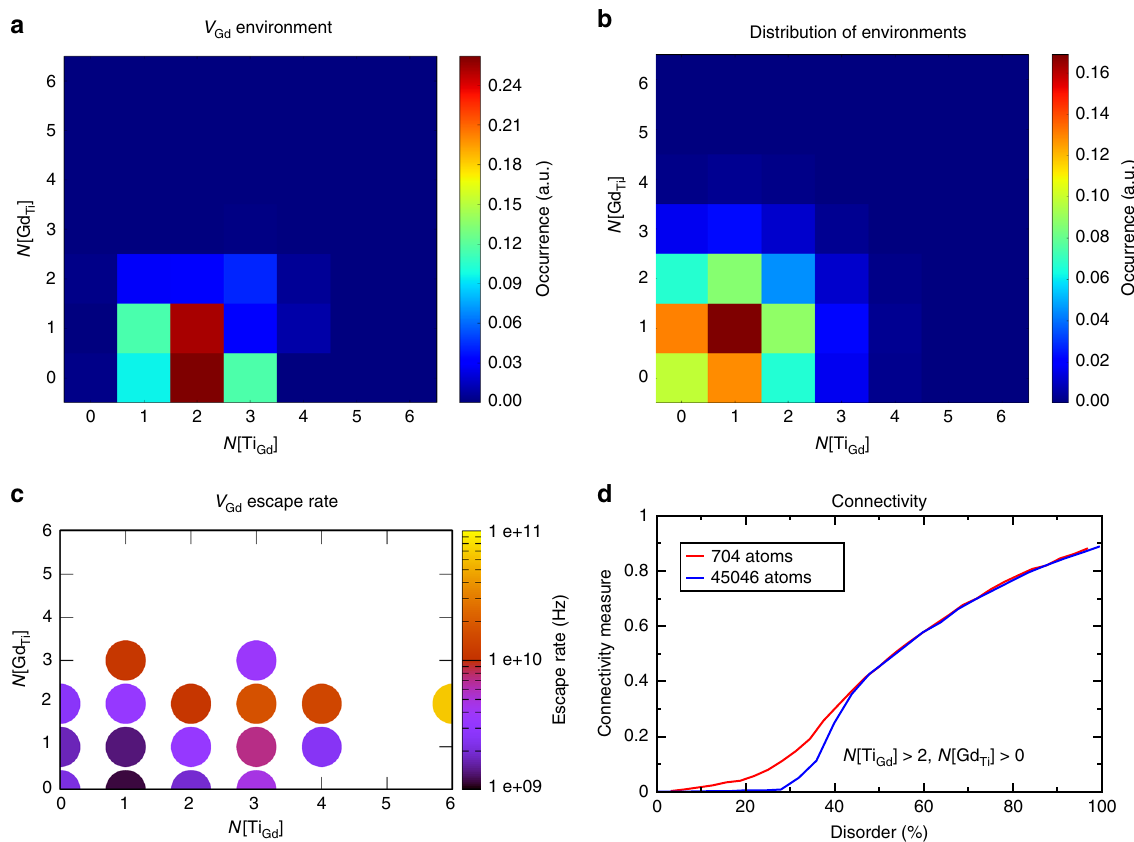
Fig. 6 Evidence for percolation diffusion in disordered pyrochlores. a Preferred cation environment for the diffusing vacancy during the ParSplice simulation with initial disorder 50.8%. The color re fl ects the total time spent by the vacancy in a given environment, normalized such that t total = 1. b Average distribution of antisite environments in a material with disorder y = 35%, corresponding to a typical con fi guration in the simulation in a . c Average escape rate for the vacancy as a function of local environment for the simulation in a . d Relative size of the largest connected components of Gd sites with at least 2 Ti antisites neighbors. (corresponding to the site most visited in a ). The size is normalized by the total number of Gd sites in the